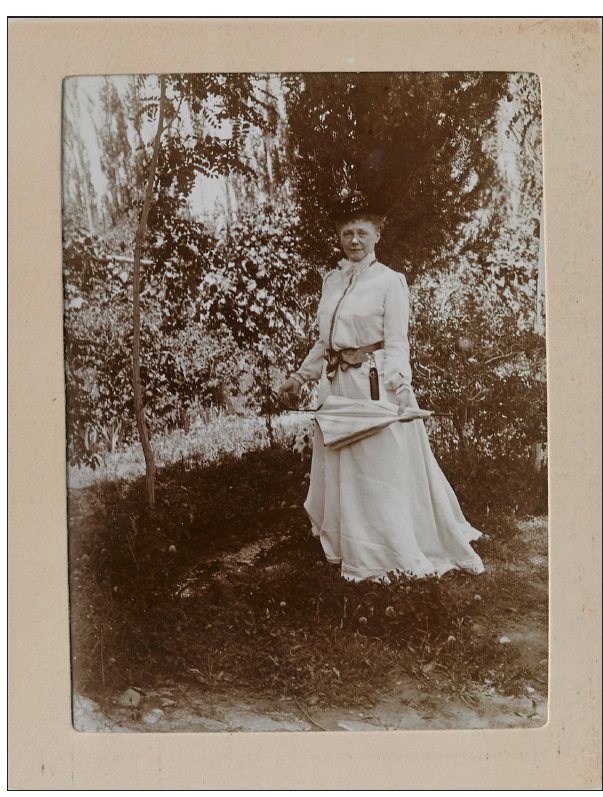
Fig. 1 : Ellen Tanner in Mahun, Iran, 1903. Photograph by Herbert Sykes, Sykes Family